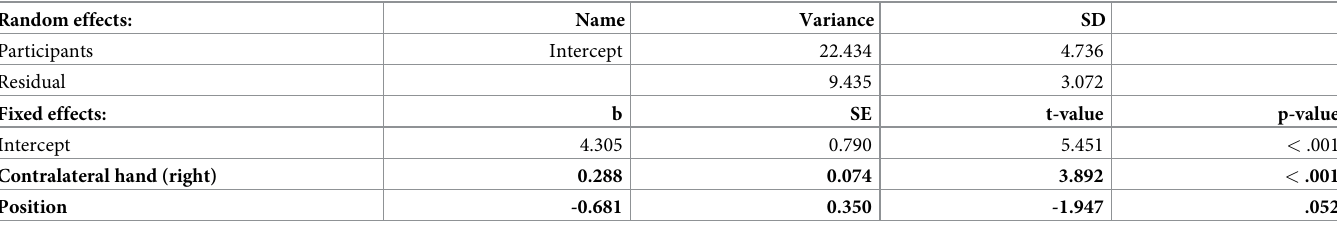
Table 3. Model 1.3. Effect of Position on the left grip force (after controlling for the contralateral force) in the time window 60–130 ms (Experiment 1). Random